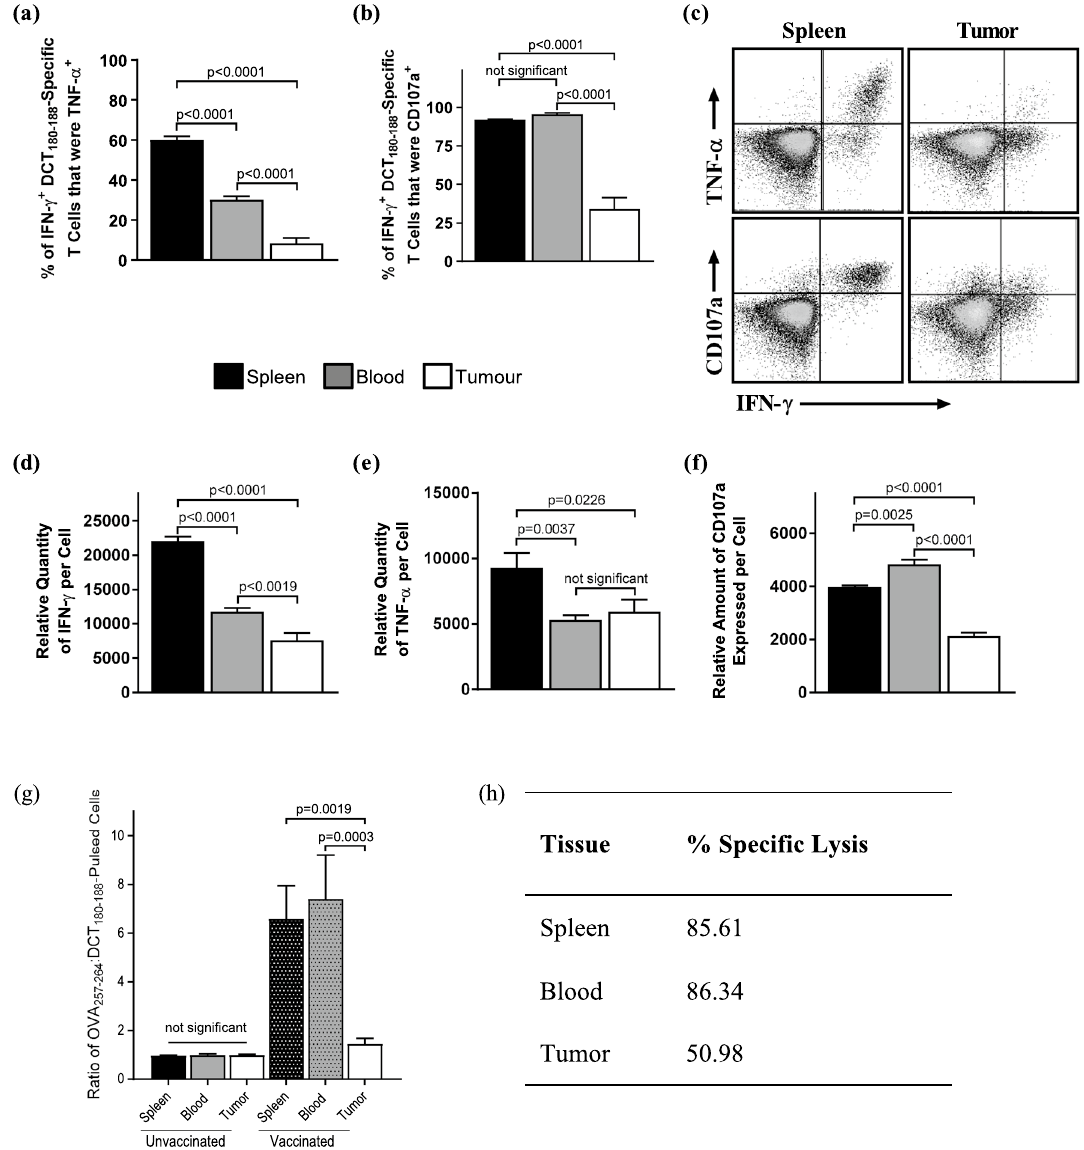
Figure 5. Transgene-specific CD8 + tumor-infiltrating T cells were functionally impaired ex vivo and inefficient at killing target cells in vivo. C57BL/6 mice with orthotopic B16-F10 melanomas (2.5 × 10 5 cells injected intradermally) were vaccinated intramuscularly with 1 × 10 8 IU of an adenovirus encoding human dopachrome tautomerase (Ad-hDCT) 4 days post-tumor challenge. Ten days after the immunization, blood, and saline-perfused spleens and tumors were harvested for ex vivo flow cytometric assessments of the functionality of CD8 + T cells specific for the immunodomiant epitope of DCT (DCT 180–188 ) using an intracellular cytokine staining assay to detect production of IFN-γ and TNF-α. The proportion of T cells that were (a) multi-cytokine producers (i.e. making TNF-α in addition to IFN-γ) and (b) capable of degranulating (by quantifying antibody-mediated tethering of CD107a to the cell surface during re-stimulation) were analyzed. (c) Representative dot plots show the phenotypic differences between splenic and intratumoral DCT 180–188 -specific CD8 + T cells (i.e. those that are IFN-γ + ) in terms of their ability to produce a second pro-inflammatory cytokine (i.e. TNF-α; upper plots) and degranulate (i.e. cells with CD107a tethered to their surface; lower plots). These plots also show the differences in the relative amounts (determined by mean fluorescence intensity) of IFN-γ, TNF-α, and surface-expressed CD107a on a per-cell basis, which were quantified in panels (d–f) , respectively. (a–f) Data were pooled from three experiments ( n = 10 mice/ group), with graphs showing means and standard error bars. Results were analyzed by one-way analysis of variance with Tukey’s multiple comparisons test. (g) The in vivo cytolytic potential of T cells was evaluated in spleens, blood, and tumors of intradermal B16-F10 melanoma-bearing C57BL/6 mice that were either unvaccinated (controls) or vaccinated intramuscularly with 1 × 10 8 IU of an adenovirus vector expressing human dopachrome tautomerase (Ad-hDCT; test group). Ten days post-vaccination, mice received intravenous and intratumoral injections (doses split evenly between the two sites) of a 1:1 mixture of ovalbumin (OVA) 257–264 and DCT 180–188 peptide-pulsed splenocytes from naïve donors. Cells were labelled with different concentrations of a fluorescent dye to allow them to be distinguished. Tissues were harvested 13 h later to quantify the ratios of OVA 257–264 :DCT 180–188 -pulsed target cells by flow cytometry. Means and standard errors are shown, with data pooled from two experiments ( n = 6 mice/group). Results were analyzed by one-way analysis of variance with Tukey’s multiple comparisons test. (h) The data from mice vaccinated with Ad-hDCT were summarized as mean percentage of target cell lysis in the three tissues that were